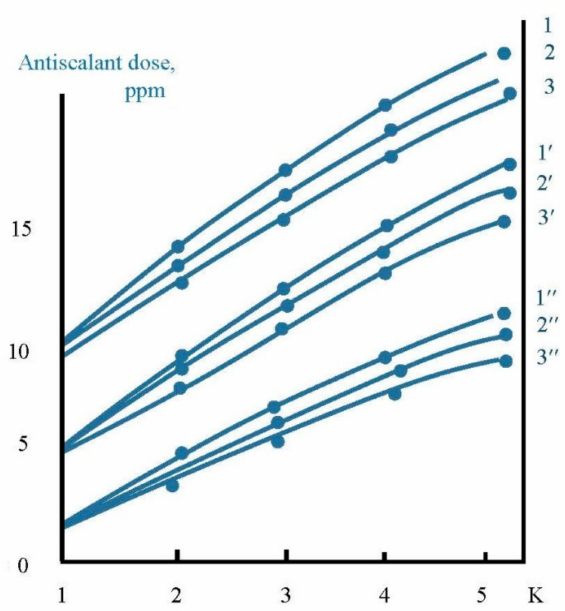
Figure 6. Dependencies of antiscalant concentrations on K during experiments: 1—Jurbysoft,